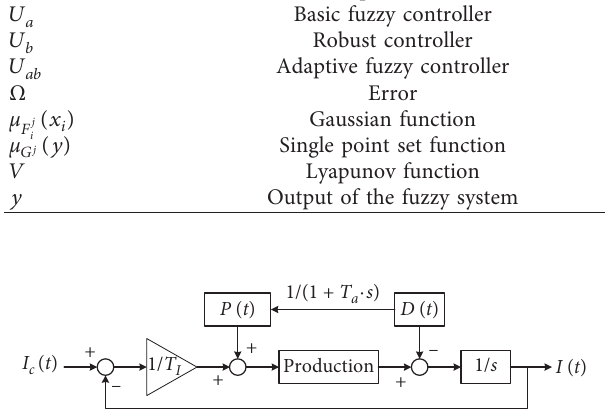
Figure 1: Production-inventory model.